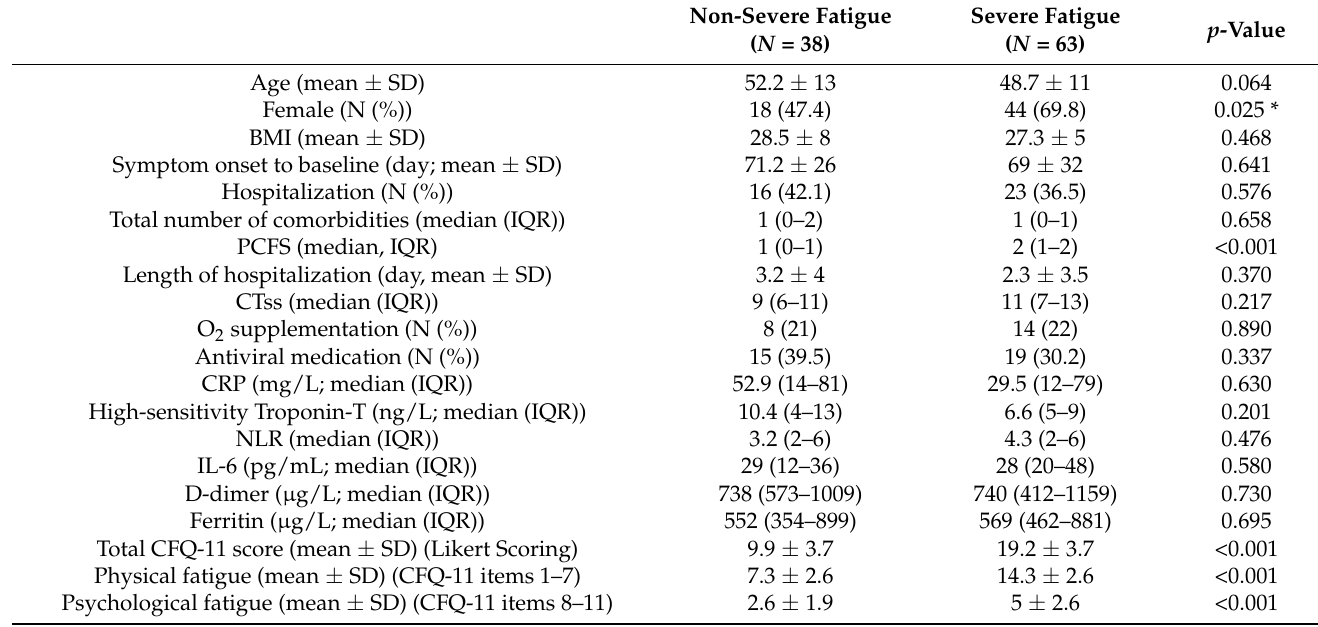
Table 2. Characteristics of study population by fatigue case status at baseline